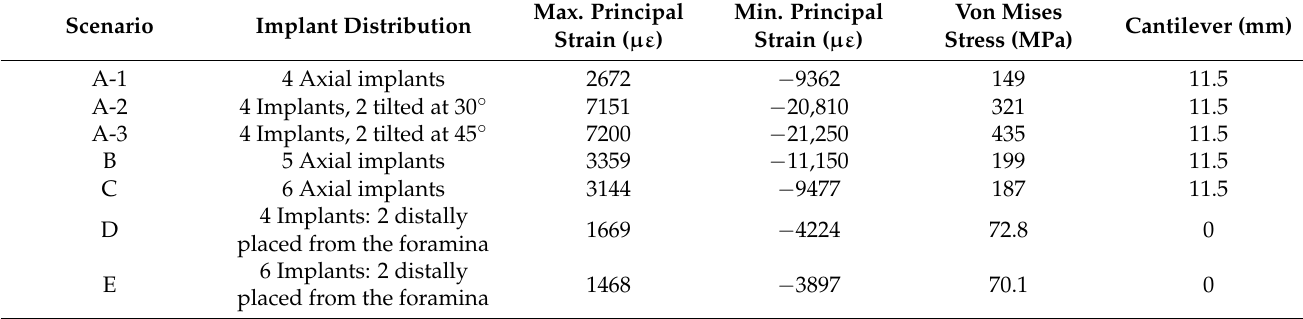
Table 3. Maximum values for the max. principal strain, minimum values for the min. principal strain, and maximum values for the equivalent von Mises stresses for each of the scenarios